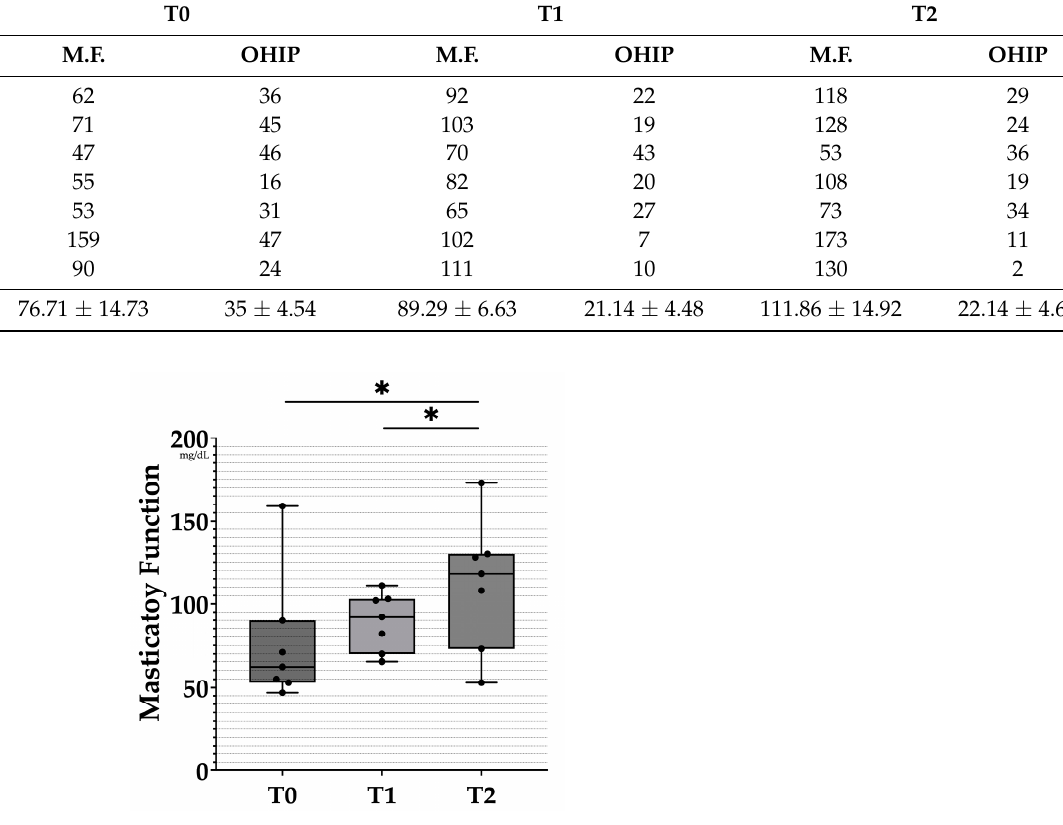
Figure 2. Box plots of masticatory function at each time point. The black dots represent the distribu- tion of raw data. T0: before the clinical remount. T1: immediately after the clinical remount. T2: one week after the clinical remount. Statistical analysis was performed with the Wilcoxon sign-rank test. Predetermined level of significance: p < 0.05